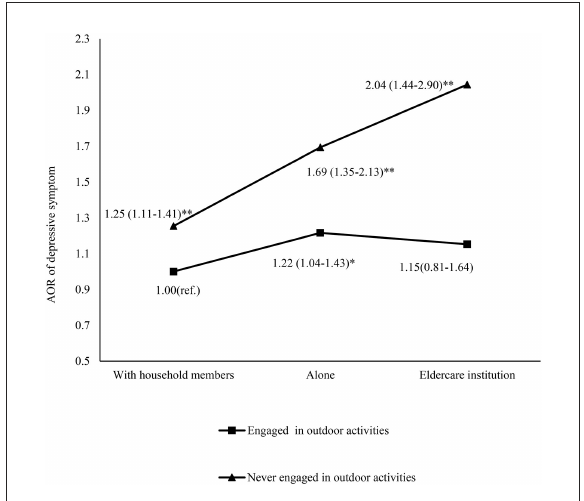
FIGURE1 Interaction effects of outdoor activities and living arrangements in depression. (Logistic regression analysis controlling for age, Hukou status, gender, living location, marital status, household income, years of schooling, number of chronic diseases, and disability; * P < 0.05; ** P < 0.001; ref., reference; AOR, adjusted odds